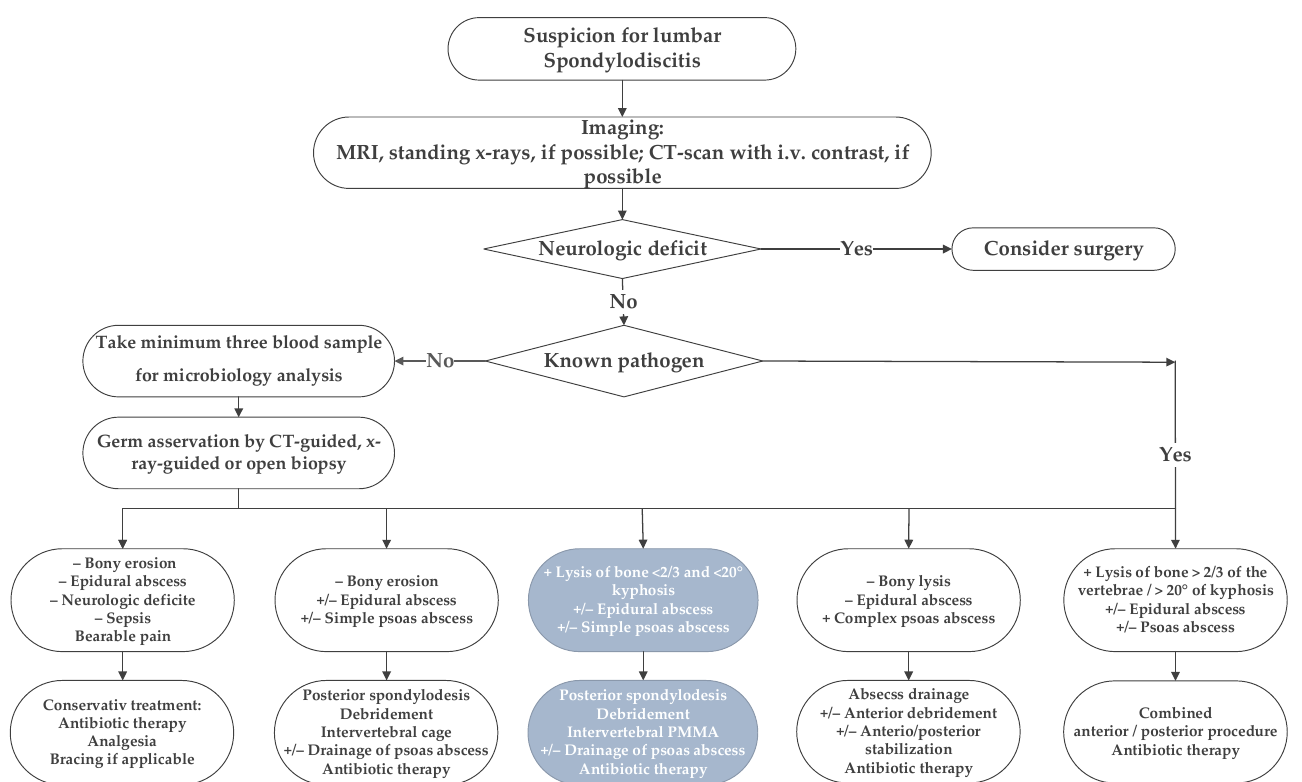
Figure 1. The in-house treatment algorithm for lumbar spondylodiscitis is illustrated. This study focused on the third group, marked with inverted colors, italic characters, and grey boxes. Blood cultures were drawn in 65/73 (89%) patients and were positive in 36/65 (55.4%). CT-guided biopsies were performed in 35/73 patients (47.9%) and were positive in 23/35 (65.7%). Intraoperative tissue samples were collected in all patients; 55/73 samples (75.3%) yielded positive. Overall, the causative organism was identified in 64/73 patients (87.7%). Polymicrobial infections were detected in three cases (3/73; 4.1%). The most frequently reported Gram-positive organisms were Staphylococcus species (26/67; 38.8%); the most found Gram-negative species were Escherichia coli and Pseudomonas aeruginosa (11/67; 16.7%) (Table 3). In 56 patients (56/73; 76.7%), the gentamicin covered the specific pathogen. In four patients (4/74; 5.5%), it was not tested, and in further four patients (4/74; 5.5%), it did not cover the pathogen. In one of the patients showing lysis Grade III around the cement, the gentamicin did not cover the pathogen found. Nevertheless, the